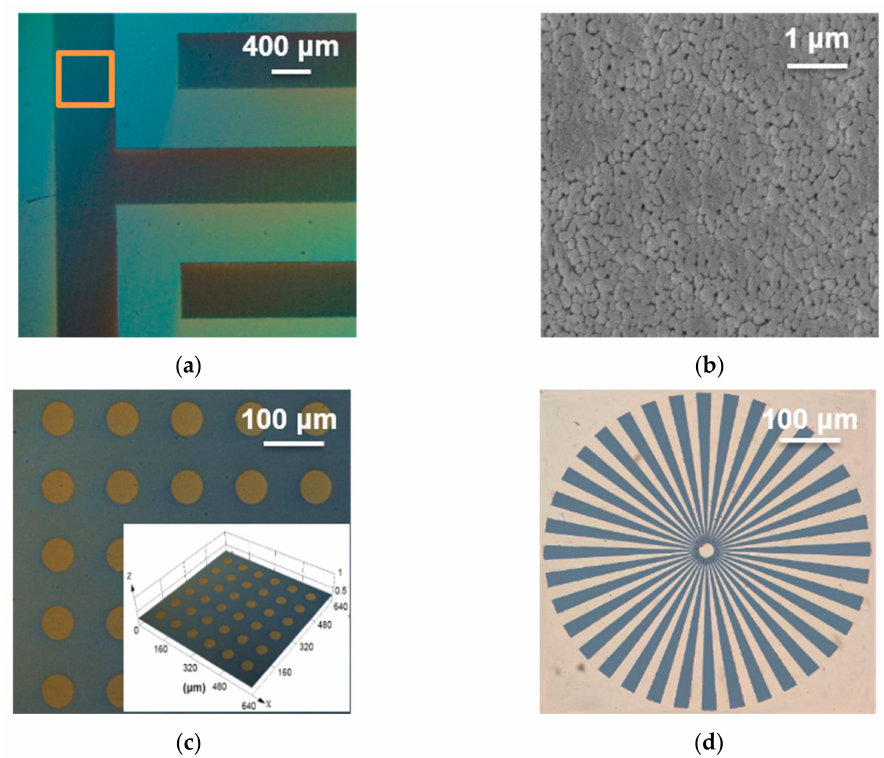
Figure 5. Micrographs of micro-patterned CaMn 7 O 12 ceramic films: ( a ) optical micrograph of the film with strip structure; ( b ) scanning electron microscope (SEM) photograph of yellow selected area in (a); ( c ) laser confocal graphs of the film with dot-matrix (the inset is its 3D graph), and ( d ) laser confocal graph of the film with radial